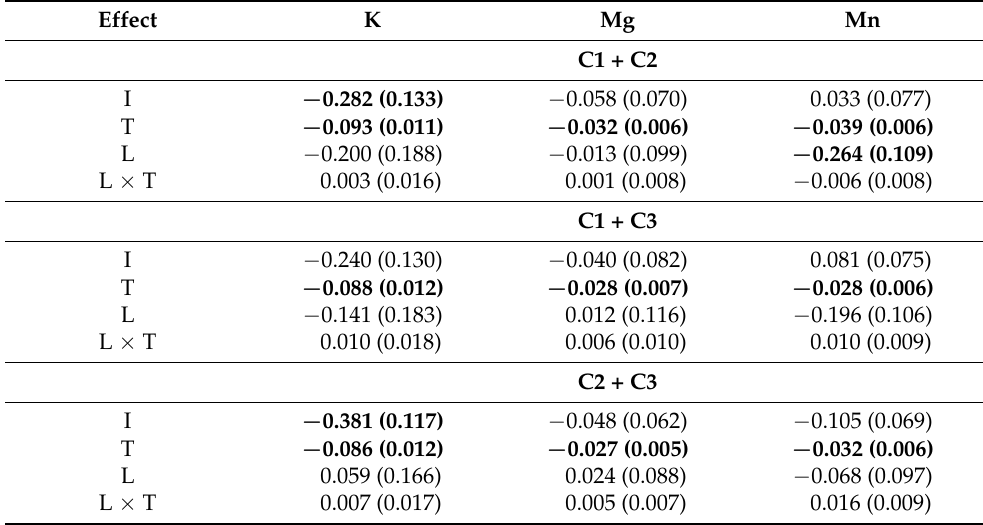
Table 4. Coefficients obtained from the adjustment of the generalized linear mixed models for the remaining nutrient content of E. grandis forest litter according to the comparison set.